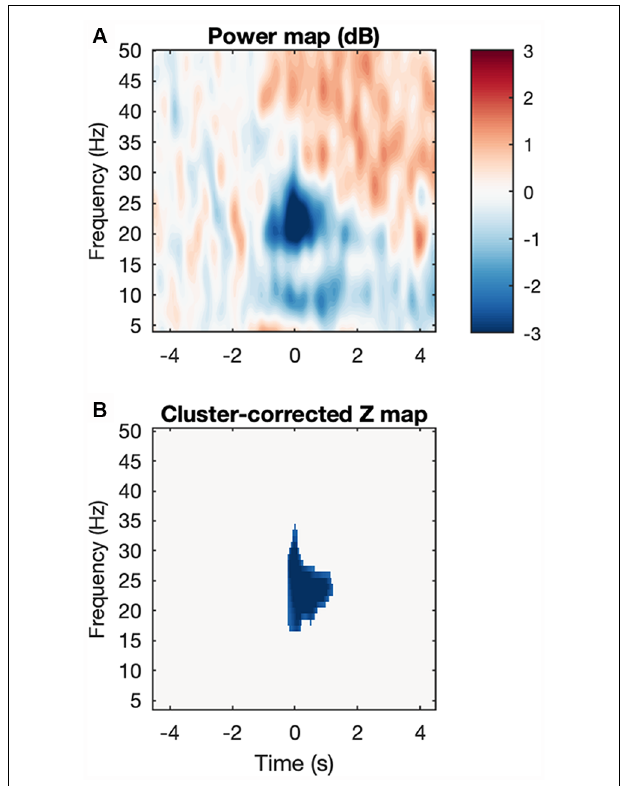
FIGURE 5 | Movement-induced high beta desynchronization. (A) Baseline-corrected grand average map, where each subject map was the average across all four conditions. (B) After cluster correction, a final cluster survives showing event-related desynchronization and located at about − 50 to 1,000 ms and 18–27